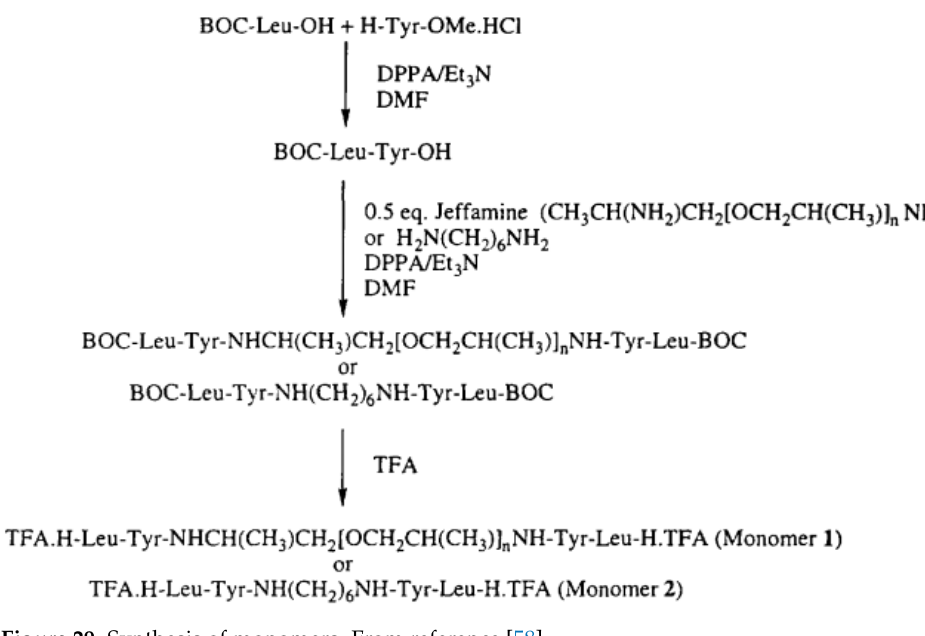
Figure 29. Synthesis of monomers. From reference [58].